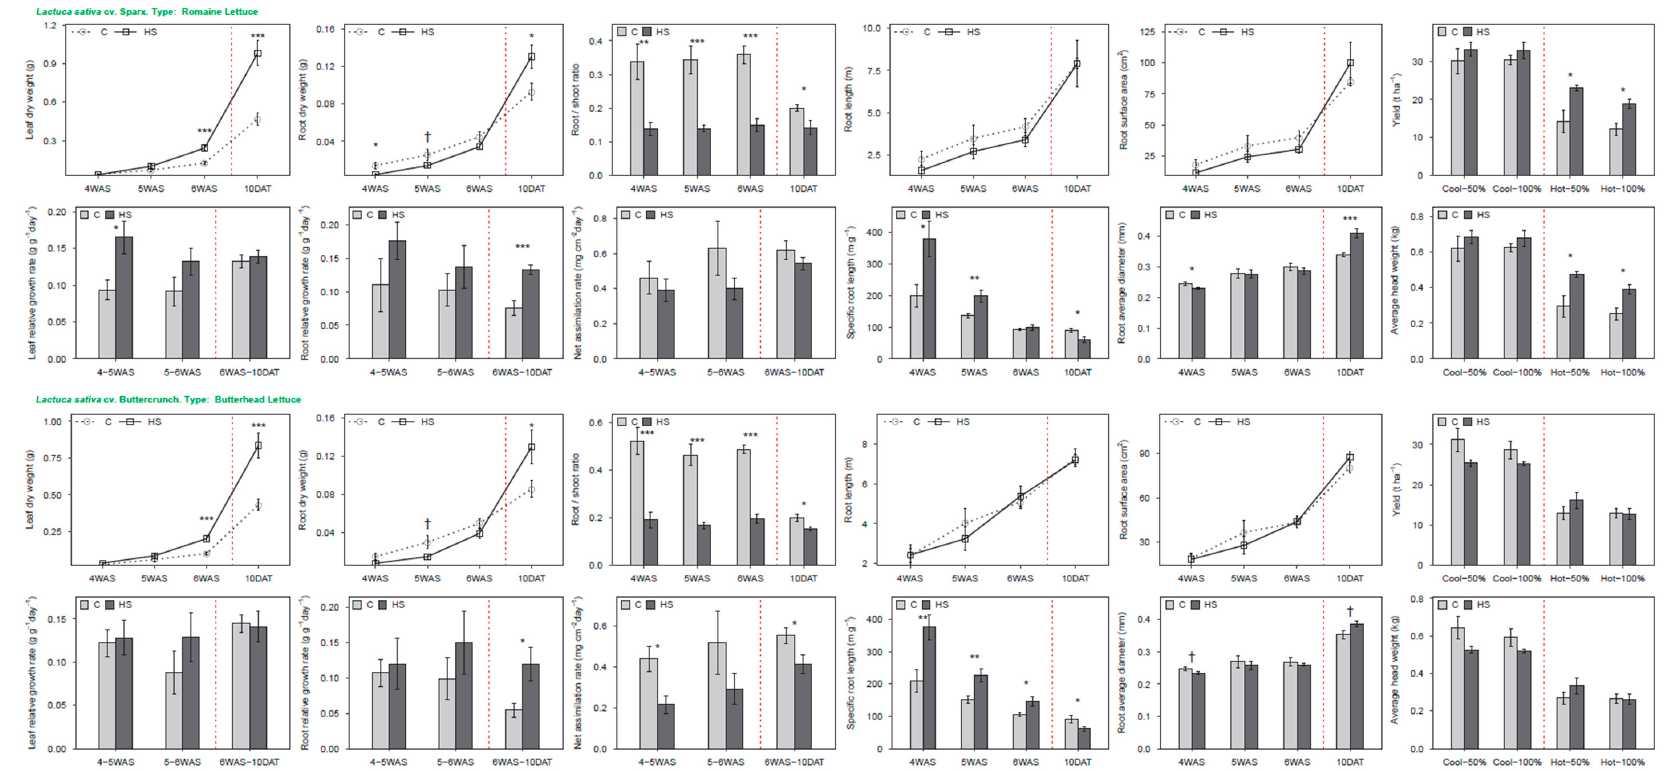
Figure 5. Lettuce seedling and transplant quality traits as affected by media amendments, yield traits as affected by amendments and irrigation during the two growing seasons. †, *, **, *** show significant difference comparing HS to control (C) at P ≤ 0.1, 0.05, 0.01, and 0.001, respectively.